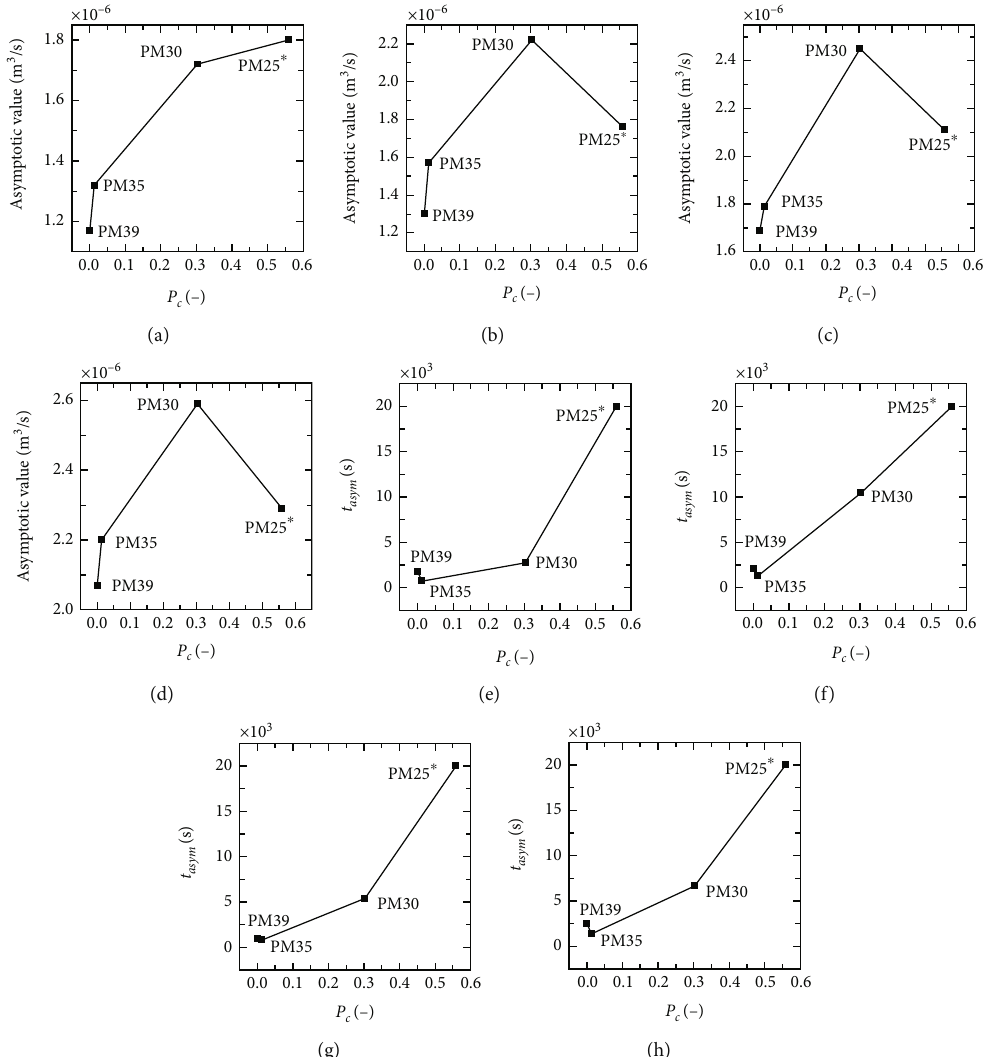
Figure 4: Asymptotic values of the dilution breakthrough curves ( dBTC asym ) and the corresponding time required to reach the asymptotic value at the cross-sections located at (a, e) 23; (b, f) 43; (c, g) 63; (d, h) 84 mm away from the tracer source in the Group 1 porous